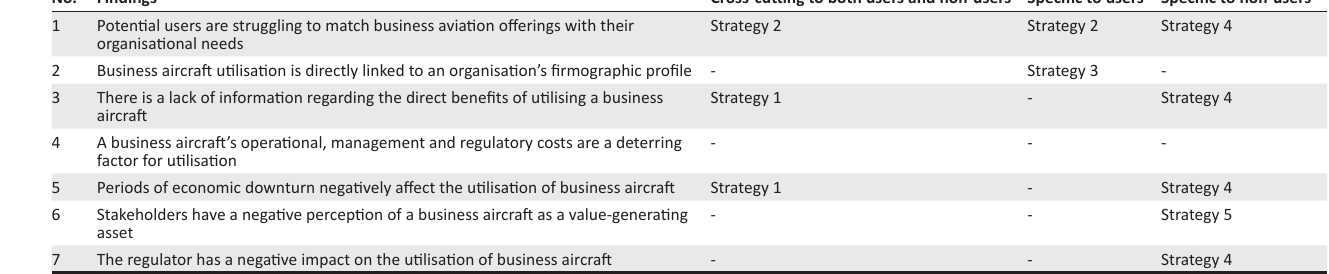
TABLE 1: Strategies to grow the business aviation